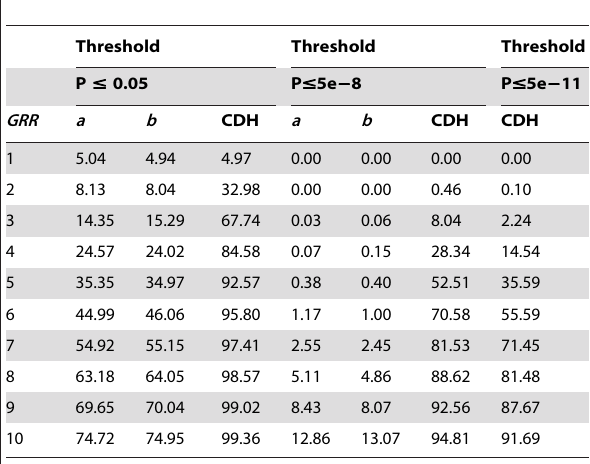
Table 1. Percentage of P values smaller than or equal to the test threshold for single SNP analysis and collapsed genotype analysis of two causal